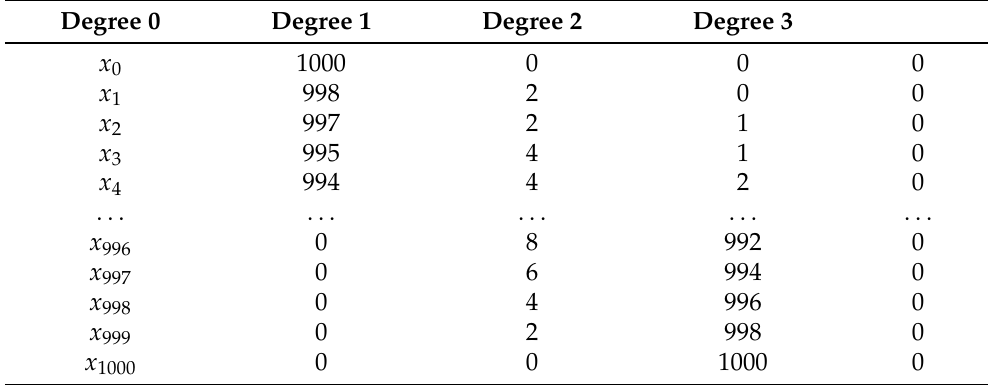
Table 3. A partial list of the degree distribution